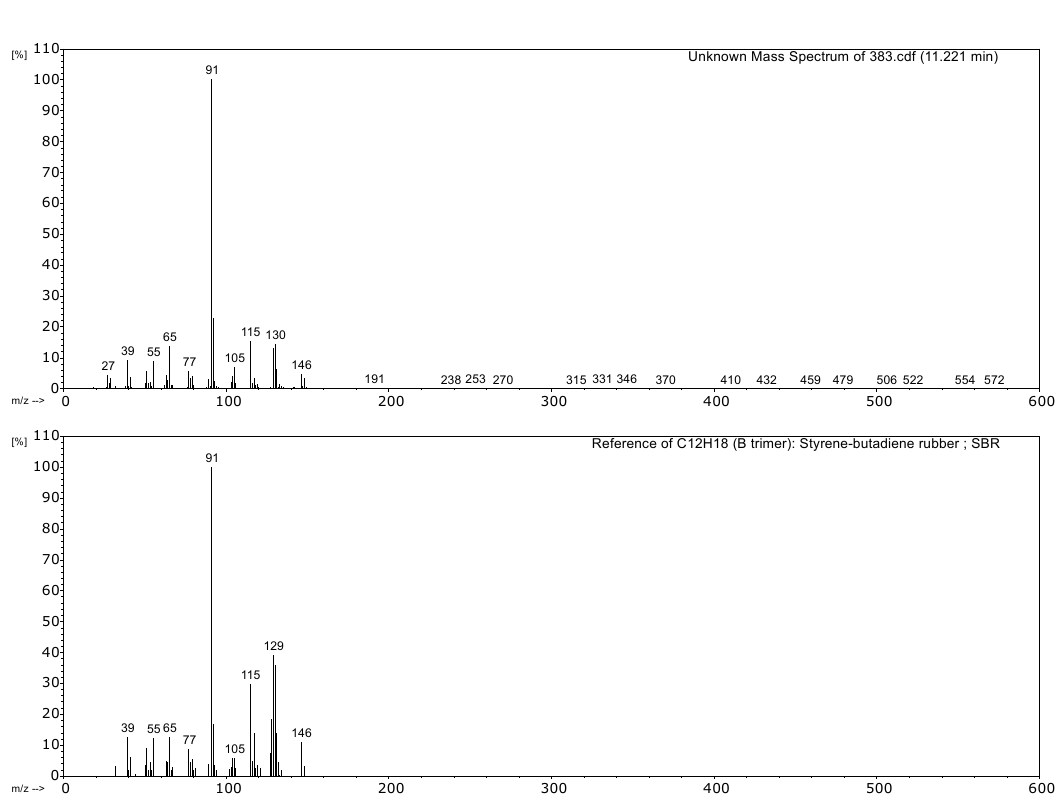
Figure 12. Mass spectrum of peak eluting at 11.22 min in the pyrogram of sample 383, along with a reference spectrum (F ‐ Search database).